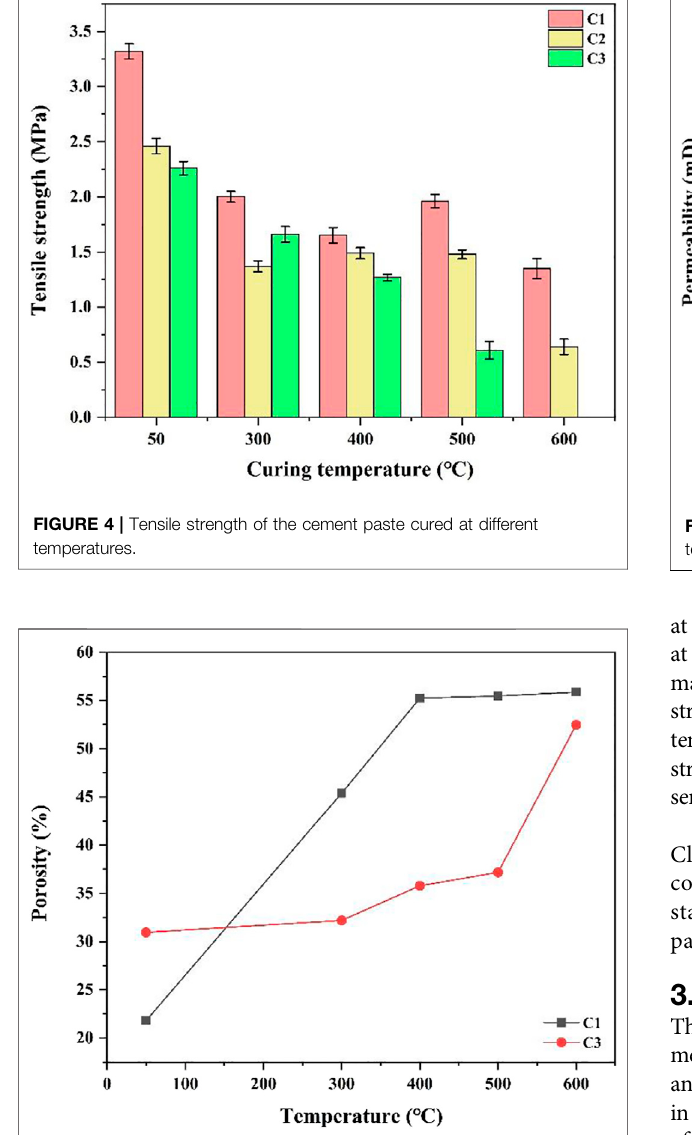
Frontiers in Materials |